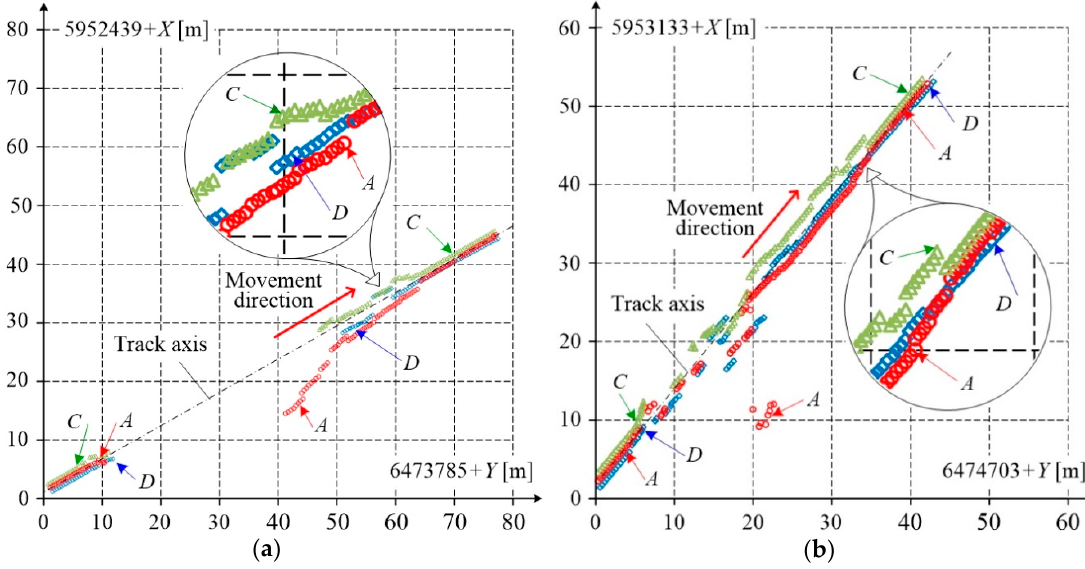
Figure 10. Results of GNSS signal loss when the measuring platform passed: ( a ) under road viaduct; ( b ) under lattice truss railway viaduct.